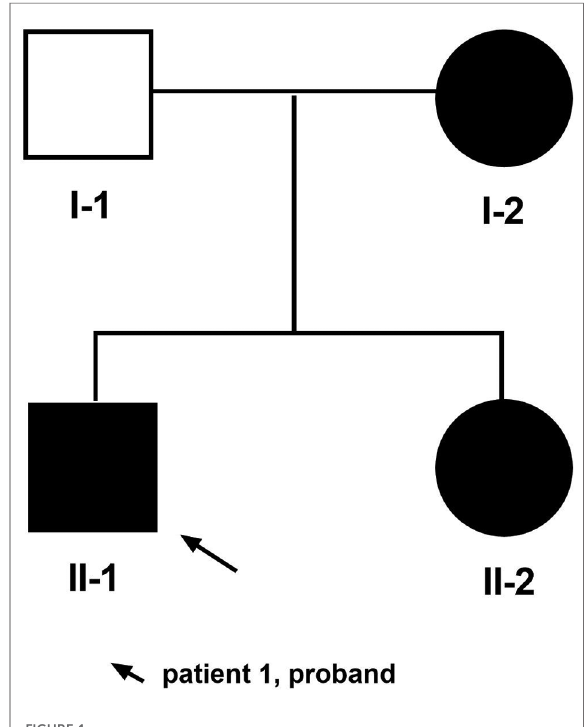
FIGURE 1 Pedigree of family. The arrow indicates patient 1 as the